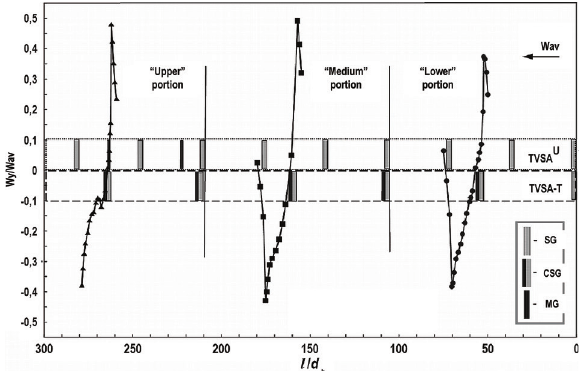
Figure 5. Distribution of the transverse velocity in the first rows of the TVSA fuel elements ( W